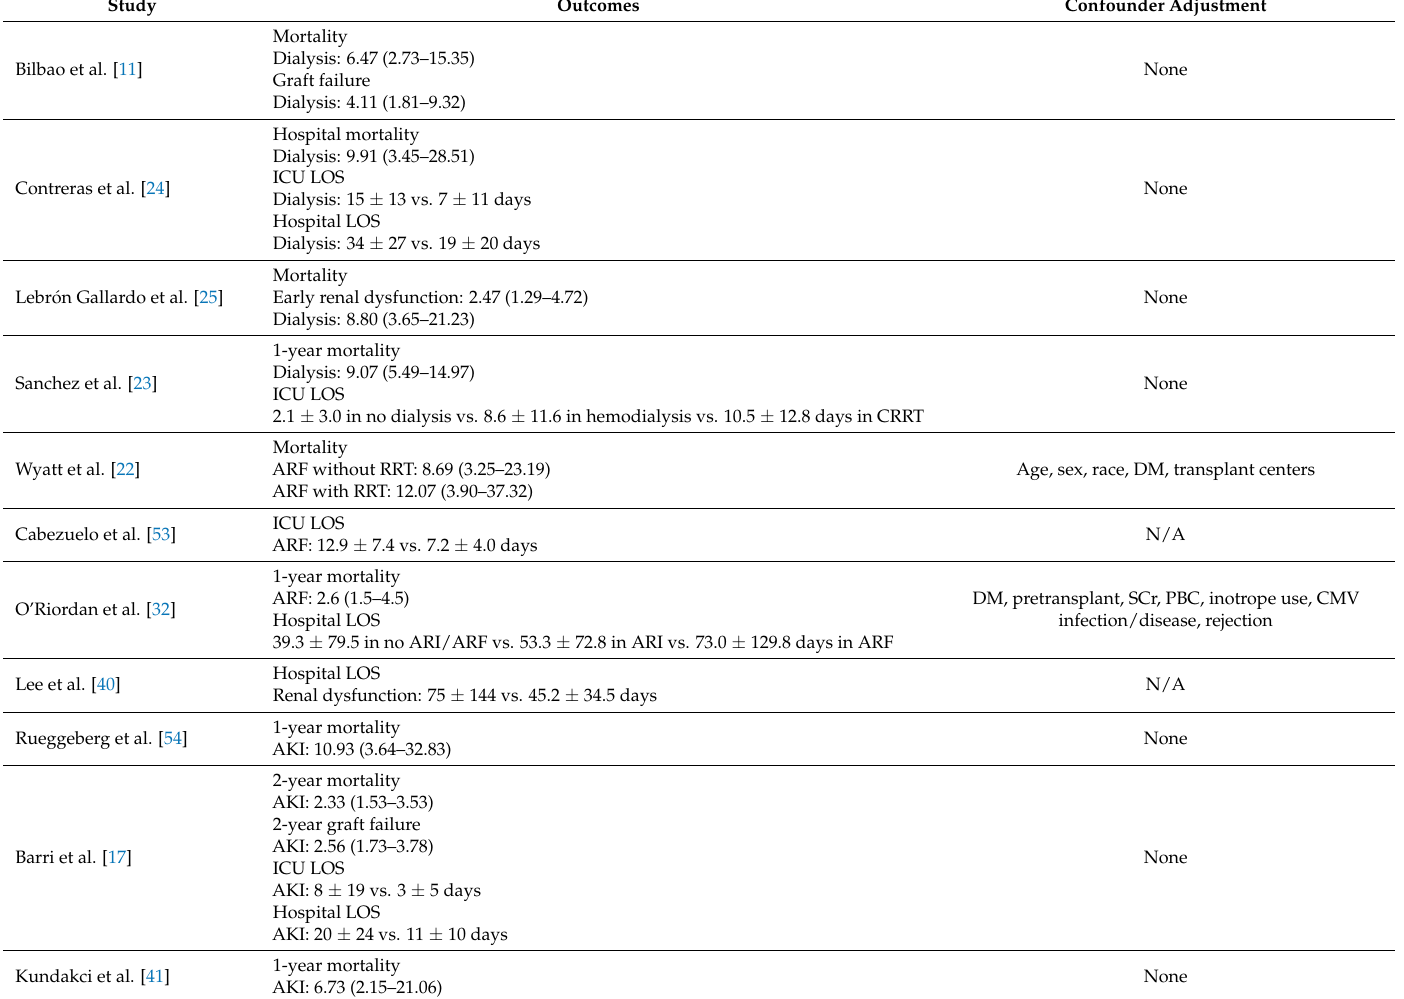
Table 3. Reported Outcomes of Post-LTx